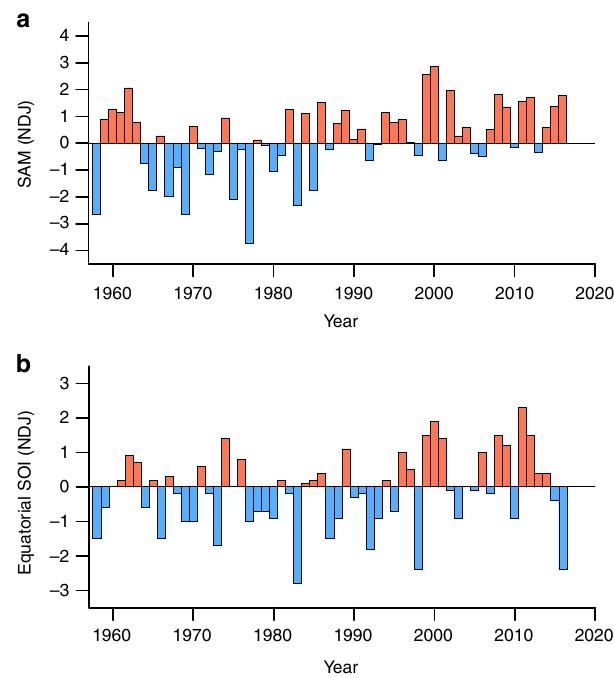
Figure 6 | Time series of November-January averaged climate indices. ( a ) Southern Annular Mode Index. ( b ) Equatorial Southern Oscillation Index. The series span 1957–2016. The year corresponds to the month of January. The last data point is for November 2015-January Modelling experiment set-up . We used the Community Atmosphere Model (CAM) version 4 to conduct a set of four 15-year idealized simulations (see Methods for details).